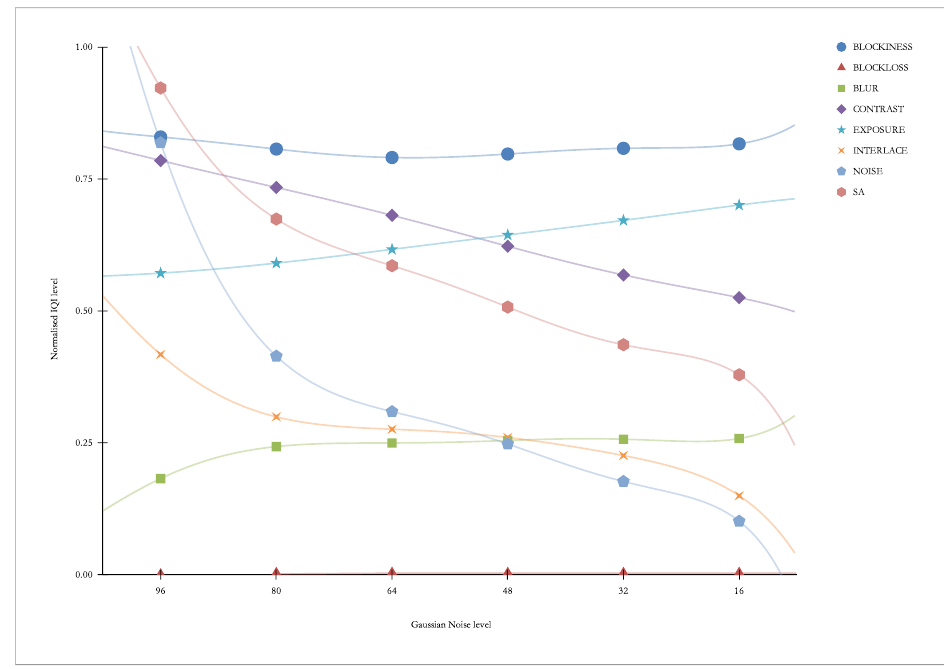
Figure 17. “Our” indicators vs. Gaussian Noise [ σ /pixels].